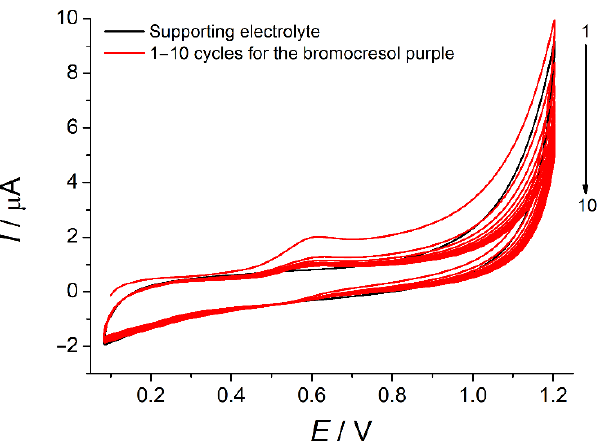
Figure 3. CVs of 25 µ M bromocresol purple on the f-SWCNTs/GCE. The supporting electrolyte was 0.1 M phosphate buffer, pH 7.0, υ = 100 mV s – 1 .